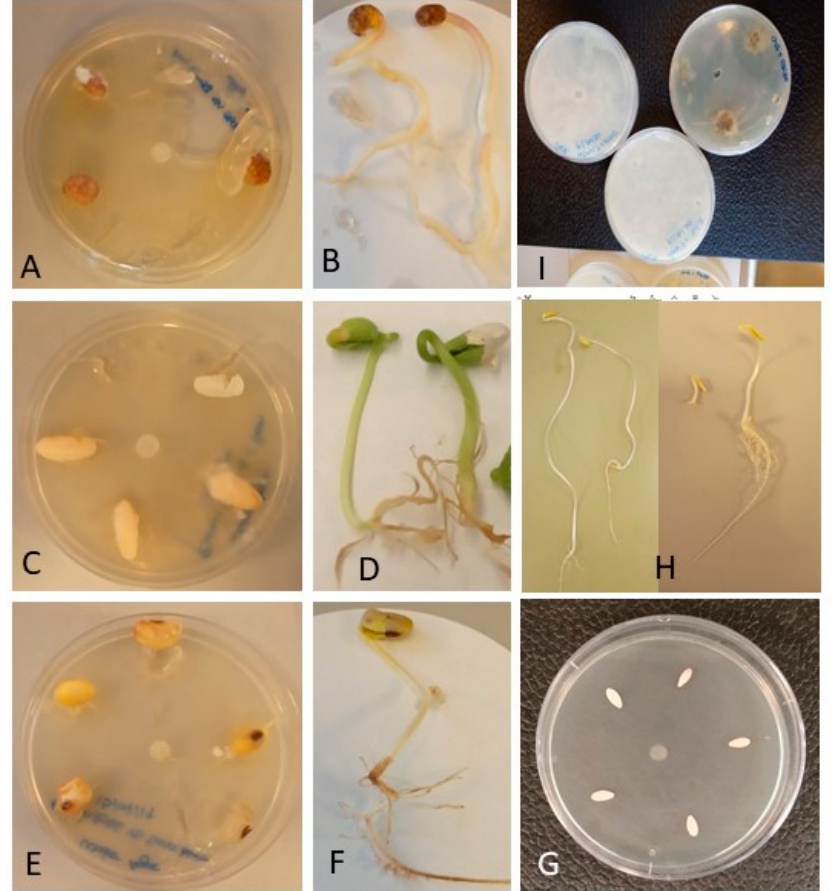
Figure 3. In vitro assay. ( A ) Blue lupin inoculated with Py. kashmirense , ( B ) Control of Blue lupin, ( C ) Common bean inoculated with Py. kashmirense , ( D ) Control of Common bean, ( E ) Soya bean inoculated with Py. kashmirense , ( F ) Control of Soya bean, ( G ) Cucumber inoculated with Py. kashmirense. ( H ) Three controls of cucumber compared with an infected seed. ( I ) Reisolation of Py. kashmirense from inoculated roots to fulfil Koch’s postulates. Roots were significantly shorter in Py. kashmirense -inoculated plants of blue lupin, cucumber and common bean ( p < 0.05) compared to controls, but no significant difference was observed for inoculated soya bean roots. Pythium kashmirense inoculation also had a significant negative impact on the fresh weight of blue lupin and cucumber plants com- pared to controls ( p < 0.05), but no significant difference was observed for soya bean or common bean compared to the respective controls (Table 1). Table 1. In vitro assay data analysis: Germination rates, pathogenicity, disease severity index, root lengths and fresh and dry weights for control and inoculated pre-germinated seeds of plant species. Data are mean ± SD for each factor, with inoculated data in bold, the test used and the p -value. NS means p > 0.05, * means p ≤ 0.05, ** means p ≤ 0.01, *** means p ≤ 0.001, **** means p ≤ 0.0001.